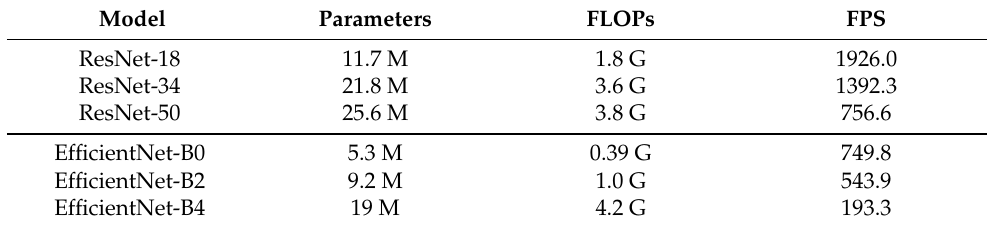
Table 4. Architecture specifications for ResNet and